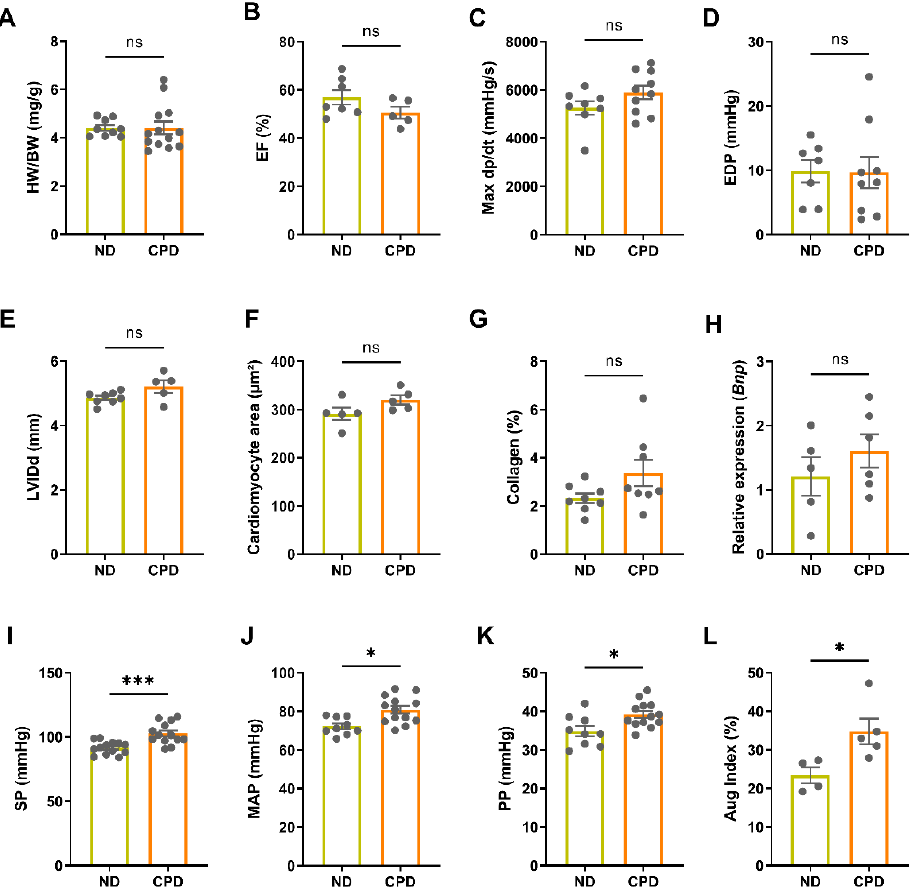
Figure 2. High phosphate intake in aged mice leads to hypertension, but not to left ventricular hypertrophy. ( A ) Heart weight-to-body weight ratio (HW/BW) is not increased in mice on CPD, relative to ND controls ( n = 10–13). ( B – E ) Ejection fraction (EF), MaxdP/dt, end-diastolic pressure (EDP), and LV internal diameter (LVID) are unchanged between CPD and ND mice ( n = 5–10). ( F ) Cardiomyocyte size is unchanged in CPD and ND mice ( n = 5). Collagen content ( G ) and cardiac mRNA expression of Bnp ( H ) is similar between ND and CPD mice ( n = 5–9). ( I – K ) Systolic (SP), mean arterial (MAP), and pulse pressure (PP) are significantly increased in mice fed CPD, relative to ND ( n = 11–15). ( L ) CPD mice have increased arterial stiffness as shown by an increase in the augmentation index (Aug Index) ( n = 4 – 5). Bars in ( A – L ) represent mean ± SEM for ND and CPD mice. * p < 0.05, *** p < 0.001 by Mann – Whitney U-test. ns, not significant.